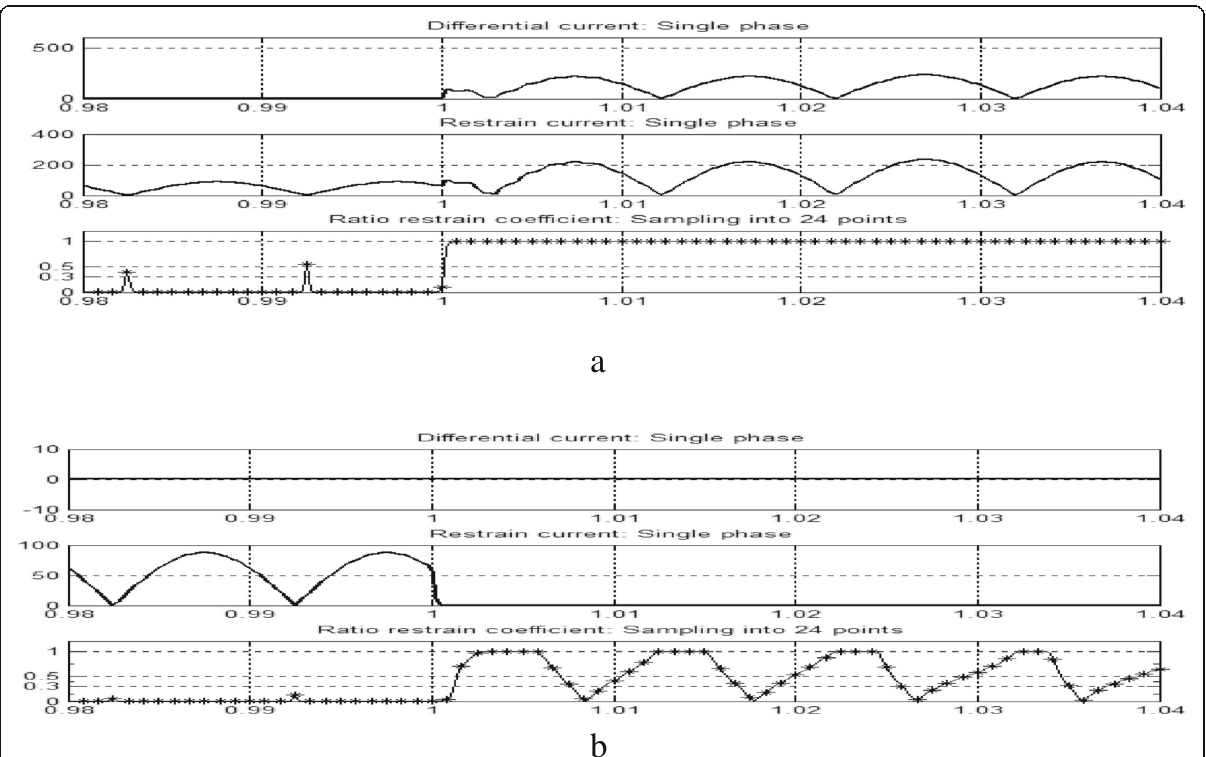
Fig. 10 The differential current, restrain current and ratio restrain coefficient of the EBDP I. a The wide differential current of Bus I. b The differential current of Bus